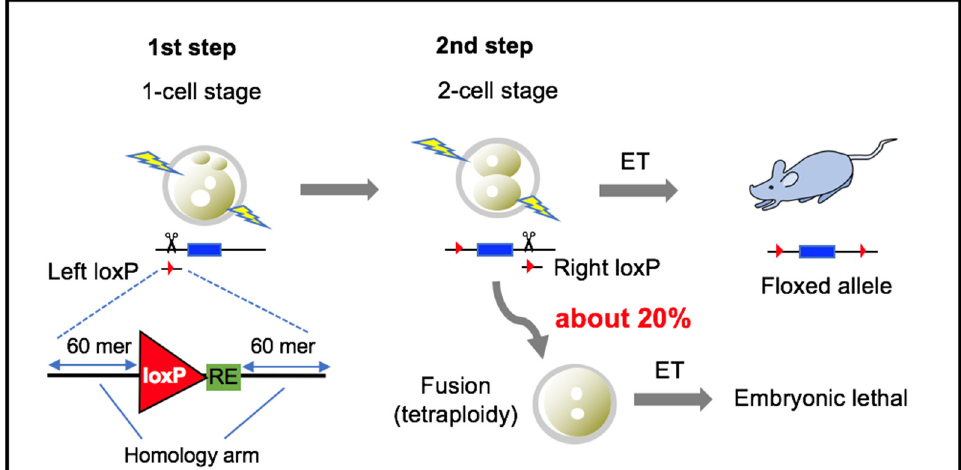
Figure 1. Schematic of sequential EP procedure. At the 1-cell stage, one loxP sequence is inserted by EP. At the 2-cell stage, the other loxP sequence is inserted by EP. Blastomere fusion occurred in 20%, reducing the number of available embryos. RE = restriction enzyme recognition site, ET = embryo